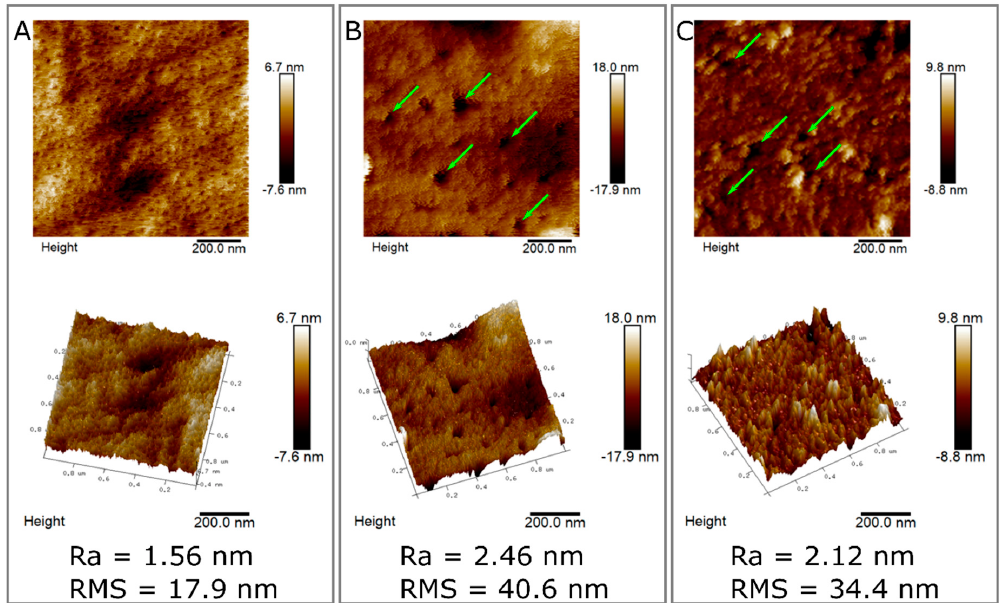
Figure 7. Surface topography measurement of unhydrolyzed and hydrolyzed CMC. Two-dimensional (upper panel) and 3D (lower panel) atomic force microscopy (AFM) images of pure CMC film ( A ), CMC film subjected to 10 μ g of cellulase enzyme ( B ), and CMC film subjected to nematodes ( C ). Pure CMC film has small holes and low roughness. Both of the films subjected to enzyme show larger holes (marked with green arrows) and a higher roughness. In the film subjected to nematodes, the holes are smaller, and roughness is lower than the film subjected to cellulase. Roughness values are shown on the bottom. All films were incubated at 37 °C for 2 h with or without enzyme or RKN and washed prior to AFM analysis .